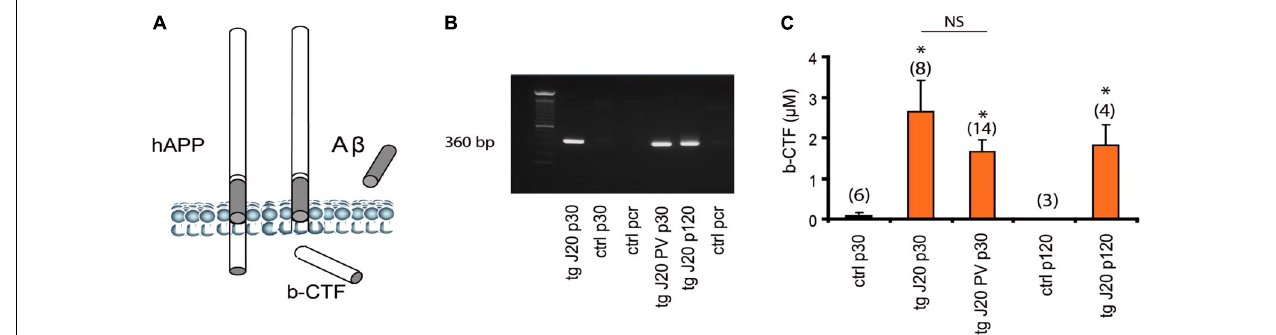
FIGURE 6 | Accumulation of b-CTF in J20 mice. hAPP processing results in intracellular fragment b-CTF, the A β peptide and secondary products (A) . Detection of hAPP gene by gel electrophoresis on a 1.5% agarose gel. 50- to 1,000-bp size markers; lane 1, J20-TG positive; lane 2, J20 Non-TG; lane 3, pcr ctl; lane 4 J20-PV-Cre and lane 5, J20-TG p120 (B) . Levels of b-CTF at 30 and 120 days (C) . Data are expressed as mean ( ± standard error of the mean) percentage of media control b b-CTF levels. (C) Both p30 J20-TG, and p30 J20-PV showed significant levels of b-CTF as detected in a sandwich ELISA (IBL, hAPP b-CTF